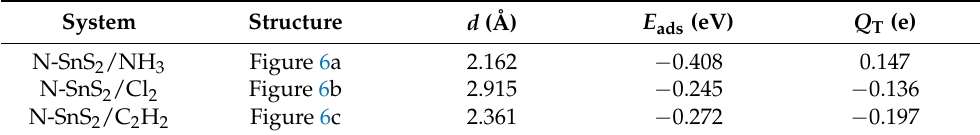
Table 3. Adsorption parameters of gas molecules on N-SnS 2 .